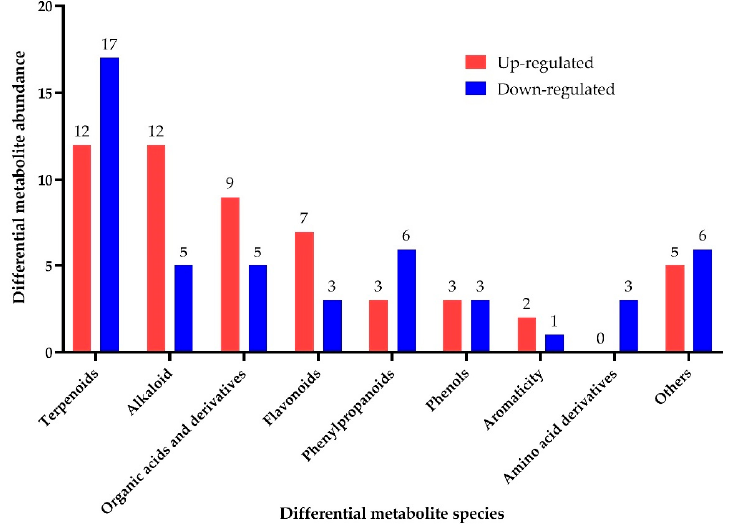
Figure 5. The results of differential metabolite category analysis of the SHLF group vs. SHL group.